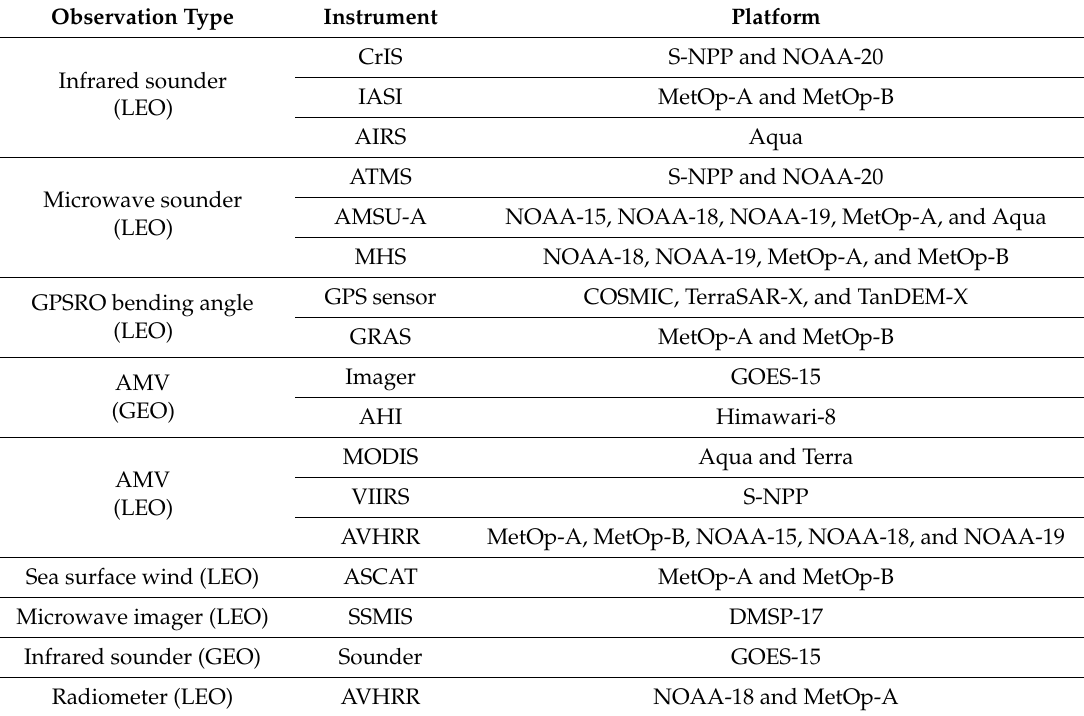
Table 2. Satellite-based observation types used in the GFS data assimilation system. See the Abbreviations for an explanation of